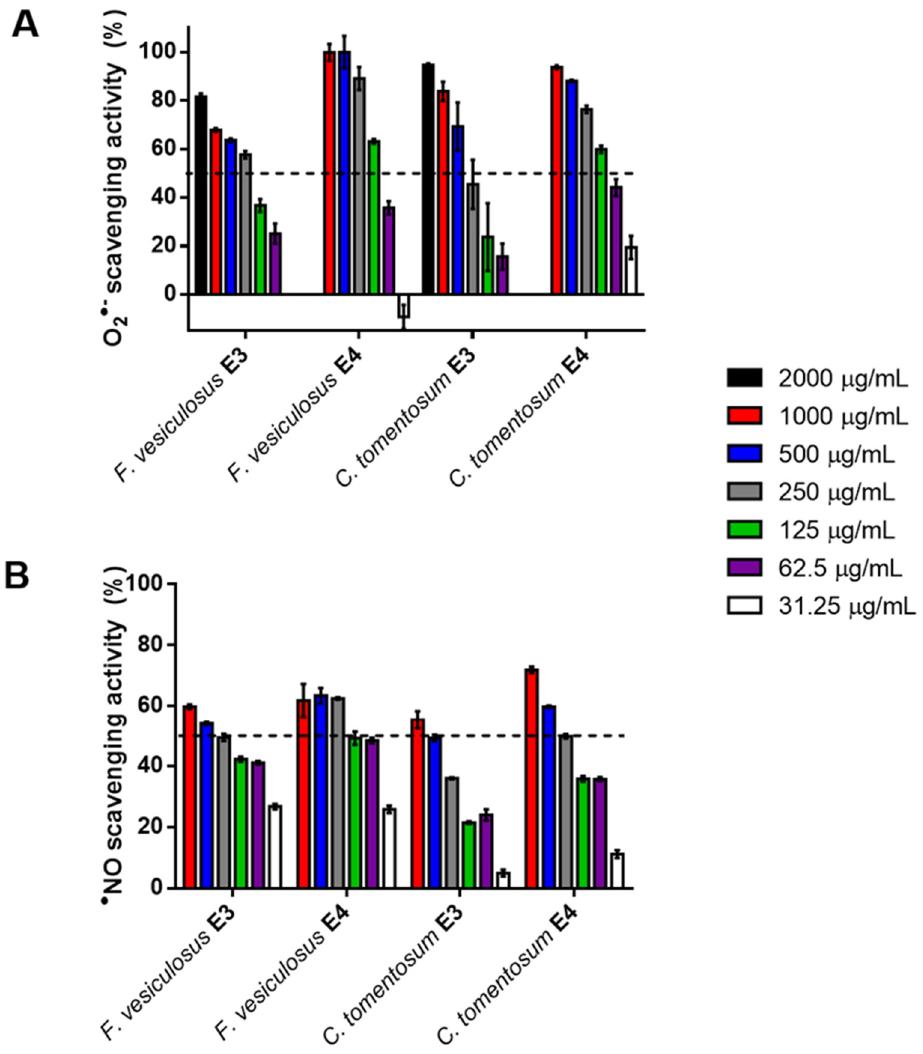
Figure 1. Superoxide anion radical (O 2 • – ) ( A ) and nitric oxide ( • NO) ( B ) scavenging activity of F. vesiculosus and C. tomentosum E3 and E4 fractions. Results are expressed as mean ± SEM of three assays performed each one in triplicate.